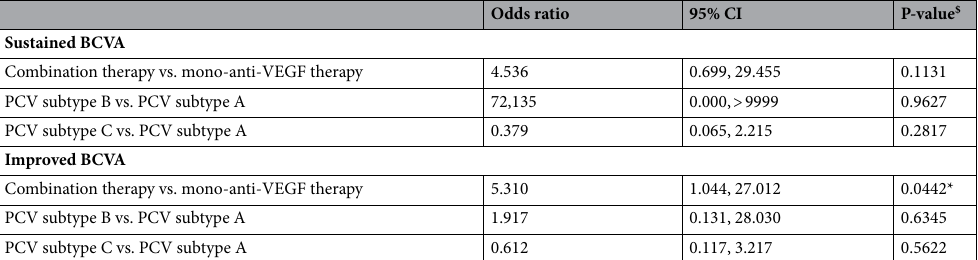
Table 2. Odds ratios for BCVA changes in different PCV subtypes and therapy choices. CI confidence interval, BCVA best-corrected visual acuity, PCV polypoidal choroidal vasculopathy, VEGF vascular endothelial growth factor. 1. Loss ≤ 4 letters of BCVA at Month 12 was defined as sustained BCVA. 2. Increase ≥ 5 letters of BCVA at Month 12 was defined as improved BCVA. $ Logistic regression model was applied. *P-value < 0.05 considered as a significant